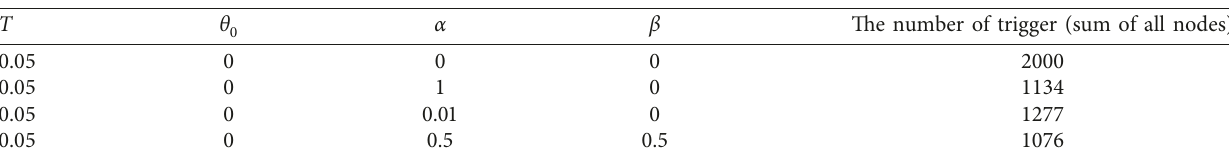
The number of trigger (sum of all nodes)